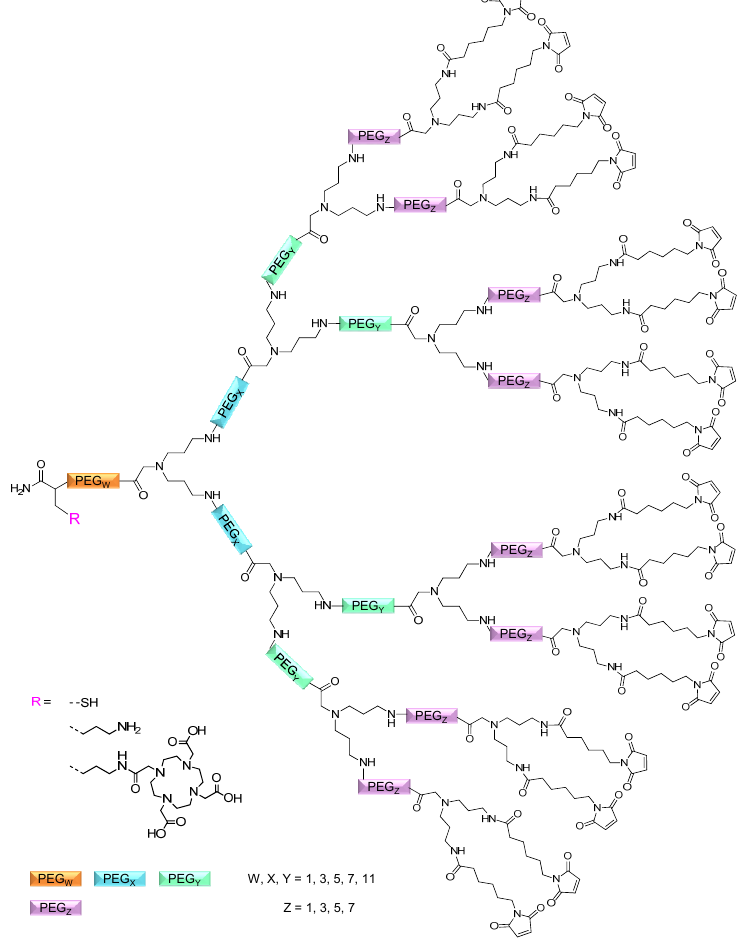
Figure 1. Schematic depiction of the general structure of the dendritic scaffolds synthesized on solid support. The dendrons comprise terminal maleimide functionalities for the efficient Michael addition of arbitrary thiol-bearing molecules, symmetrical branching units, oligoethyleneglycols of differing lengths for modular molecular design and tailored distances between two adjacent dendron surface functionalities as well as the possibility to introduce a chelator or thiol functionality for radiometal labeling or biomolecule conjugation,